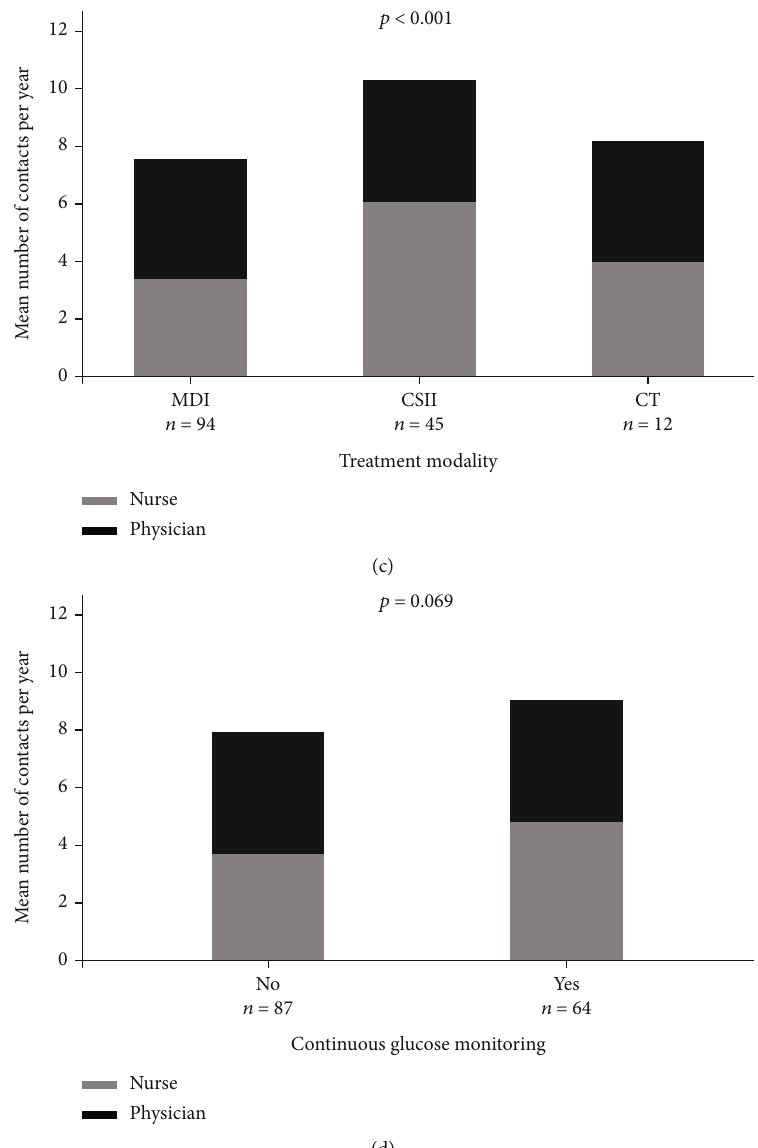
Figure 1: (a – d) Number of healthcare contacts in relation to age at (a) consultation, (b) native language, (c) treatment modality, and (d) use of continuous glucose monitoring. Global P values derived from linear regression. Number of healthcare contacts refers only to patients with a type 1 diabetes duration of > 1 year ( n = 151